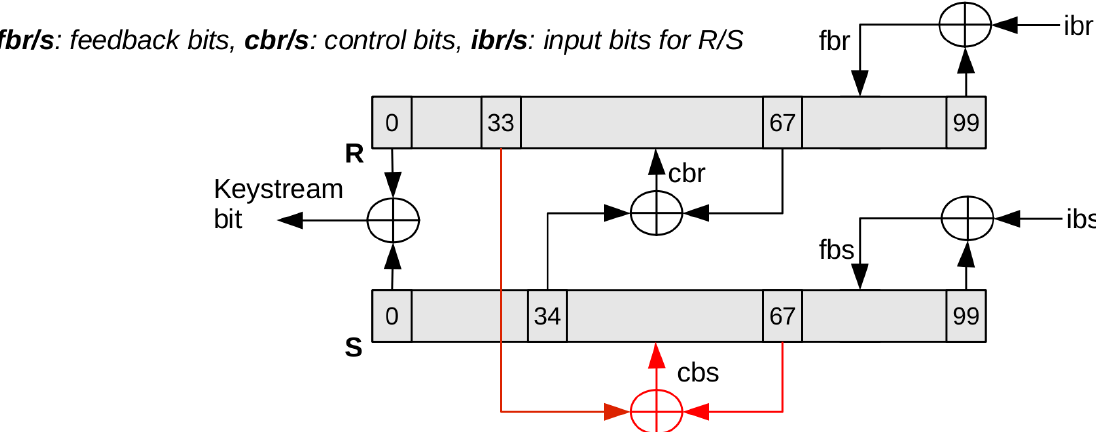
Figure 1. MICKEY 2.0 architecture with no